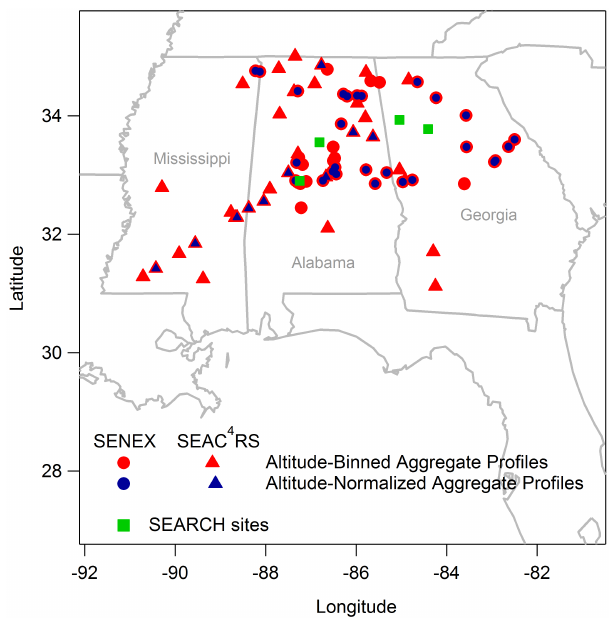
Figure 1. The locations of the vertical profiles from the SENEX (circles) and SEAC 4 RS (triangles) and SEARCH monitoring sites (green squares). The markers (both red and blue) are the locations of afternoon profiles used to construct the altitude-binned aggre- gate profile that includes 74 profiles: 41 from SENEX and 33 from SEAC 4 RS. The blue markers show the location of the profiles used to construct the altitude-normalized aggregate profile that includes 37 profiles: 27 from SENEX and 10 from SEAC 4